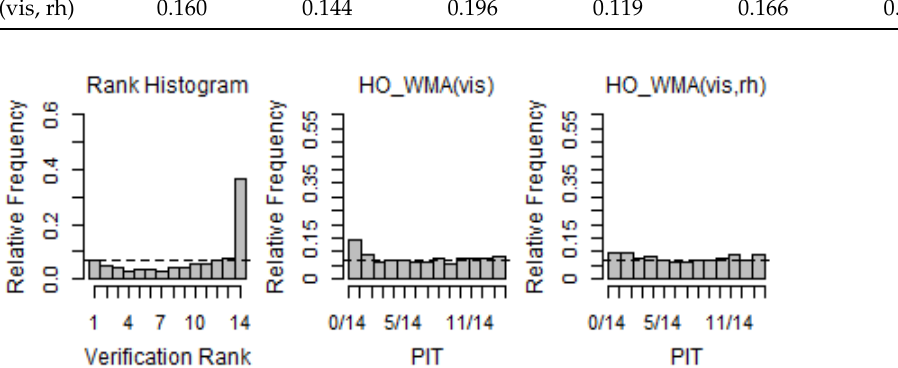
Figure 4. Verification rank histogram of raw ensemble forecasts and PIT histograms of WMA models for Station 110 (2018–2019 DJF).